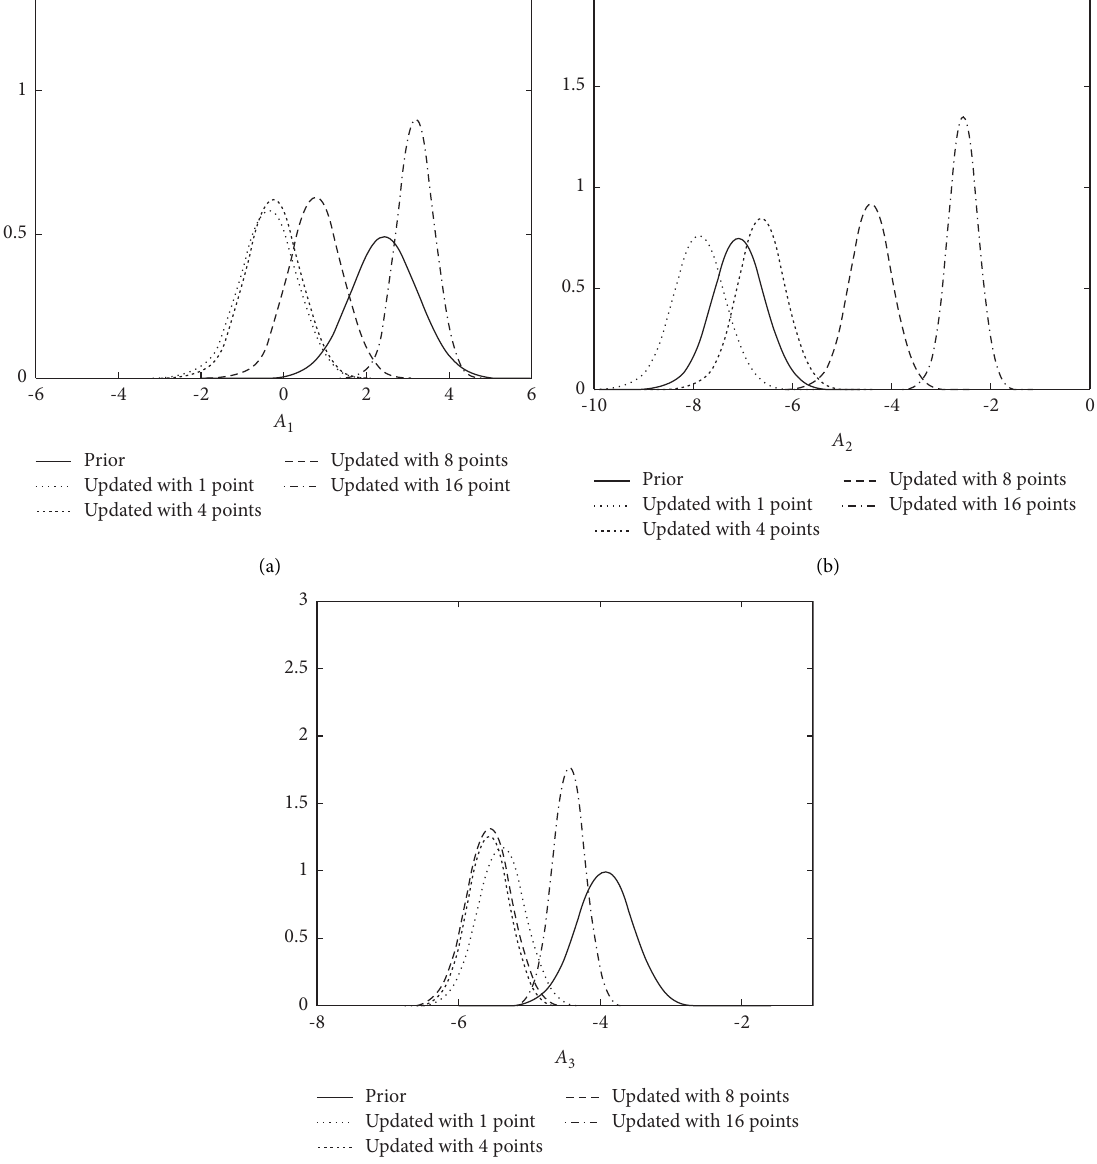
1 , (b) parameter A 2 , and (c)